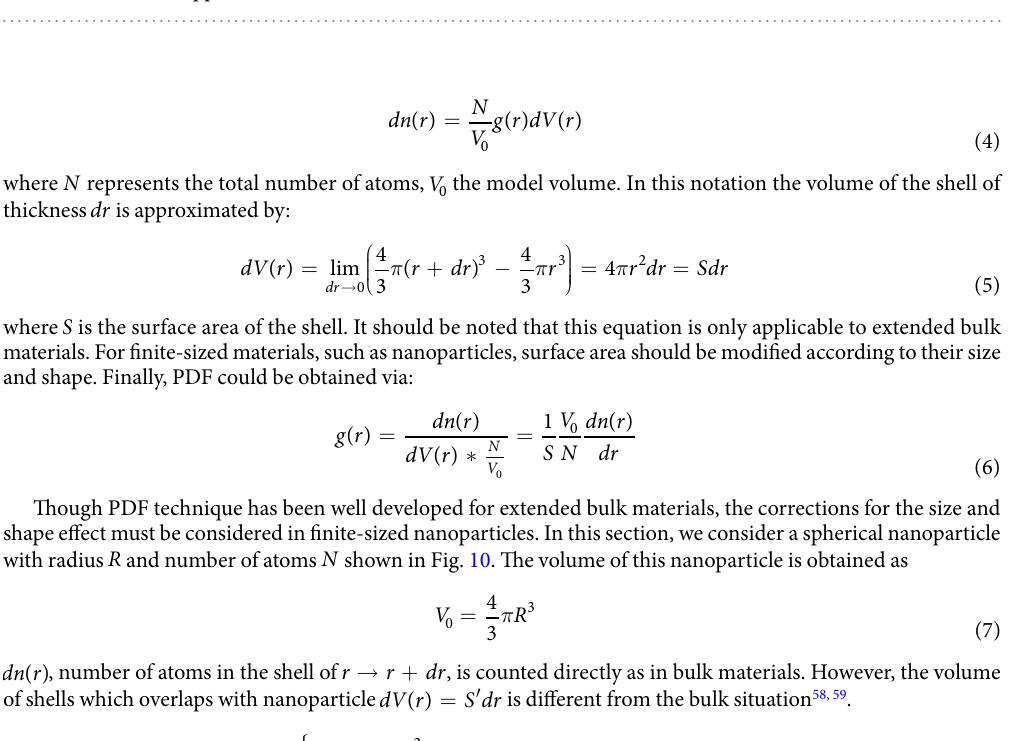
Figure 10. Sectioned diagram of a spherical particle. ( a ) Shell with radius r locates inside the nanoparticle. ( b ) Surface area of overlapped